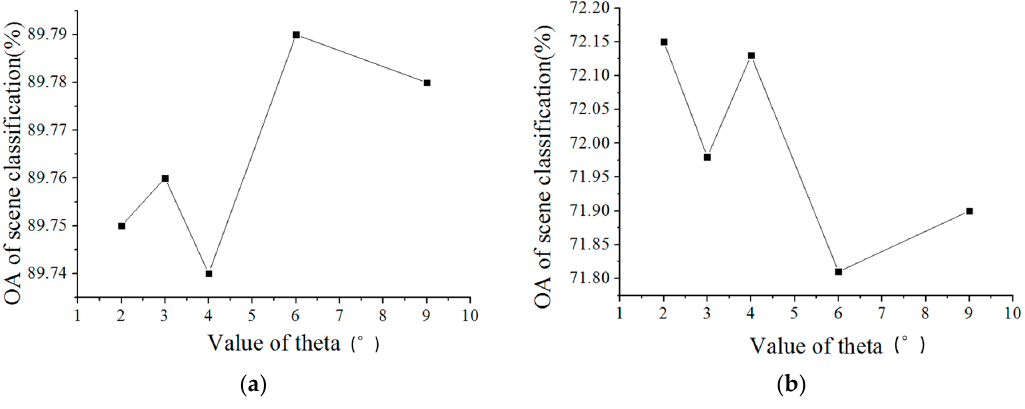
Figure 16. Sensitivity analysis of ∆ θ : ( a ) the scene sematic category understanding result for the USGS dataset; and ( b ) the scene sematic category understanding result for the Wuhan IKONOS dataset.